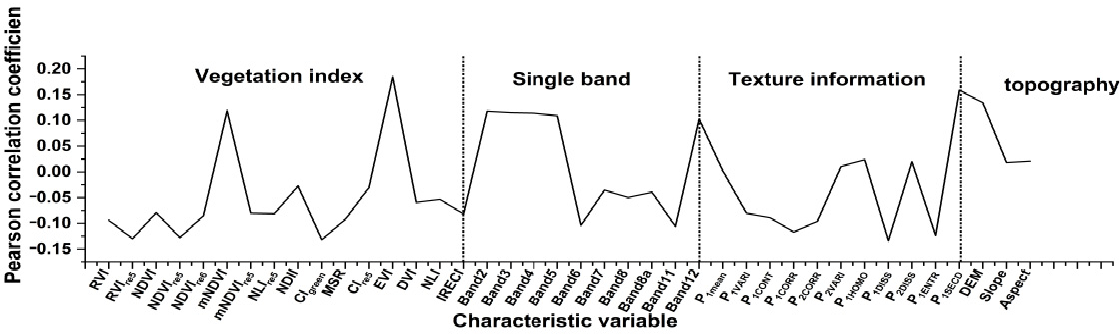
Figure 3. Pearson’s correlation between characteristic variables and forest aboveground biomass.